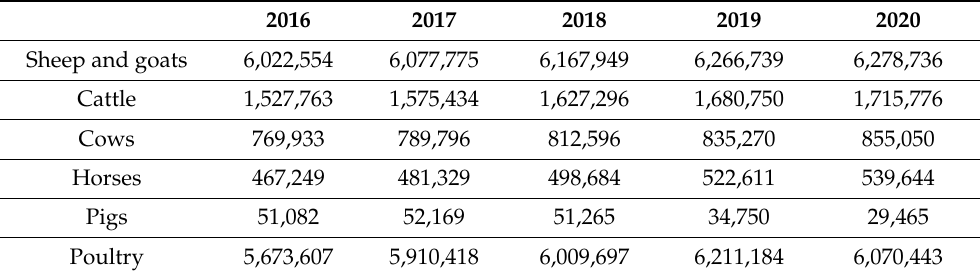
Table 1. Number of livestock in Kyrgyzstan from 2016 to 2020. Adapted from www.stat.kg, accessed on 3 February 2022